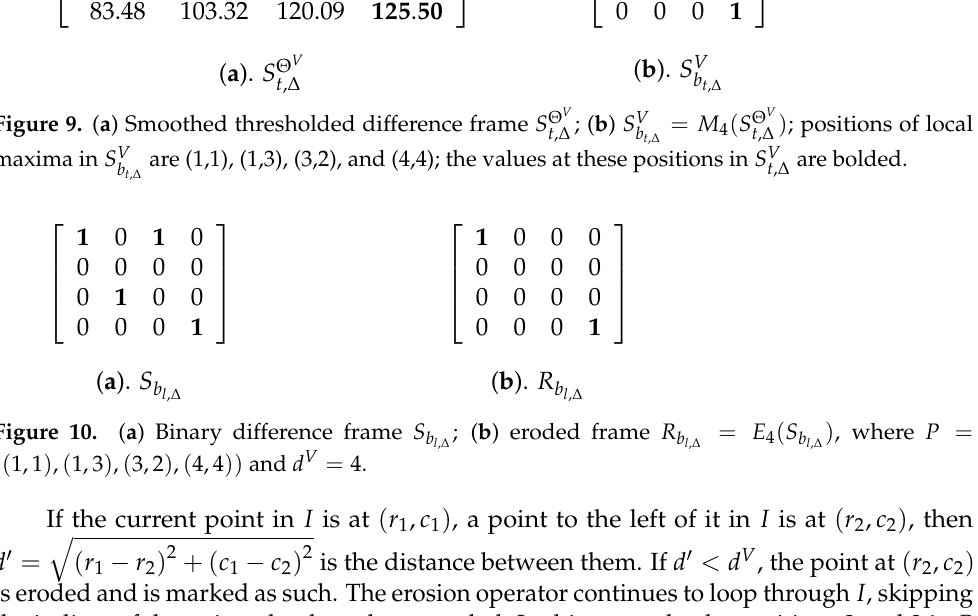
= M ( S Θ V ) ; positions of local ; ( b ) S V 4 t , ∆ t , ∆ b t , ∆ are bolded. t , ∆